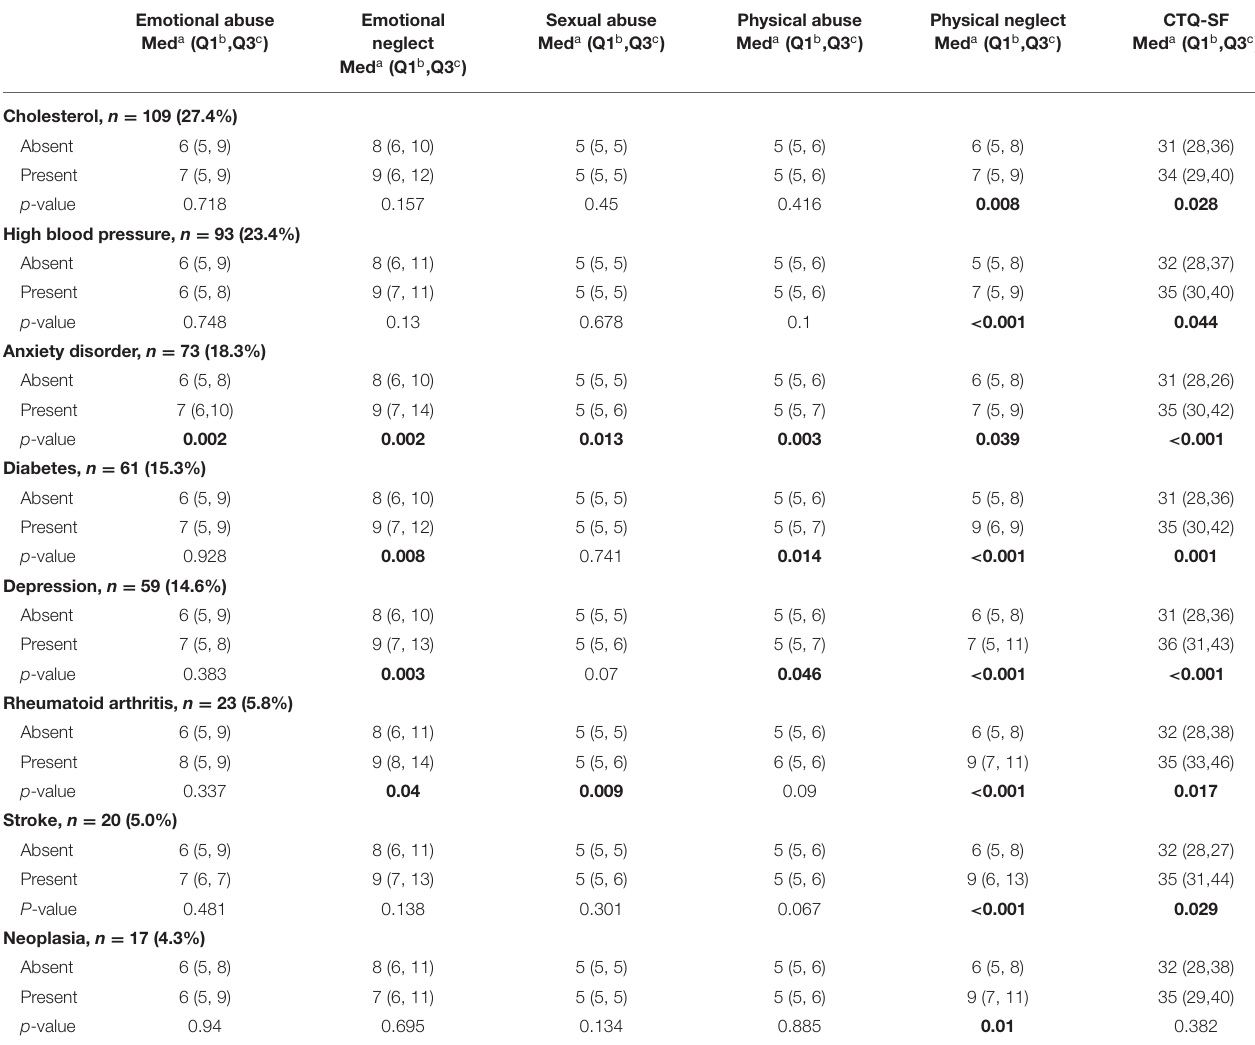
CTQ-SF Med a (Q1 b ,Q3 c